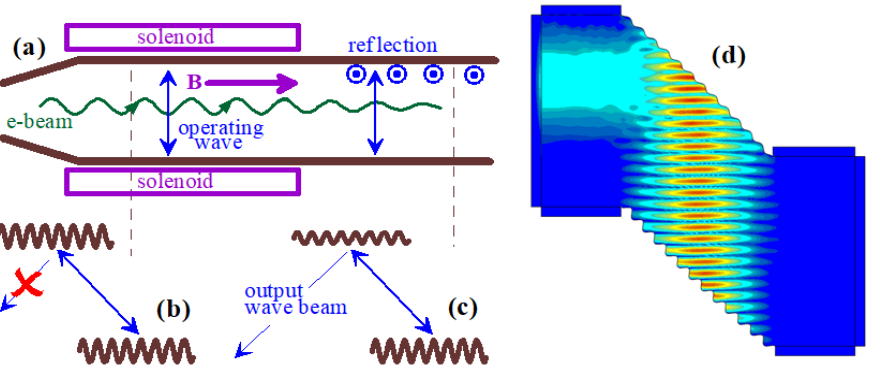
Figure 8. ( a ) Schematic of the gyrotron with the wave output system. ( b ) Transverse cross-section of the operating cavity. ( c ) Transverse cross-section of the system of formation of the output wave beam. ( d ) Simulations of the planar system of formation of the output wave beam, where a not deep enough upper grating radiates a traveling wave in the left direction.